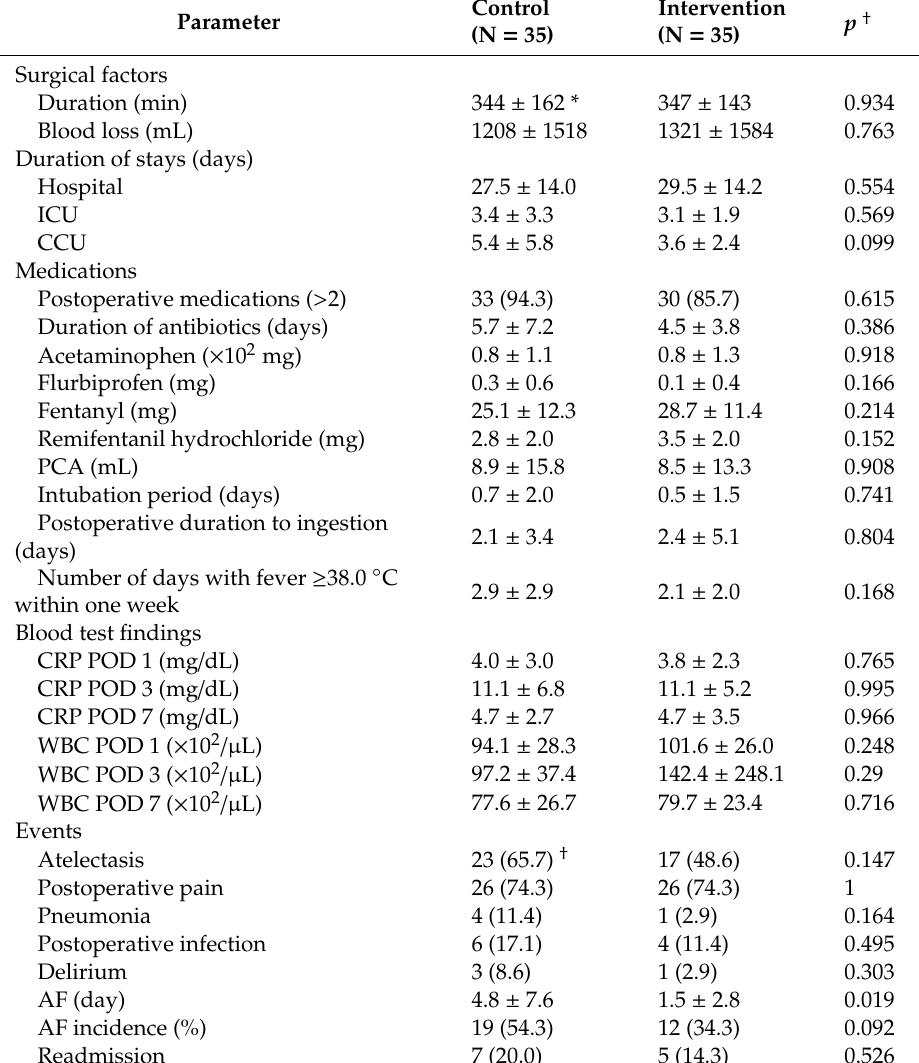
Table 3. Di ff erences in postoperative conditions between control and intervention